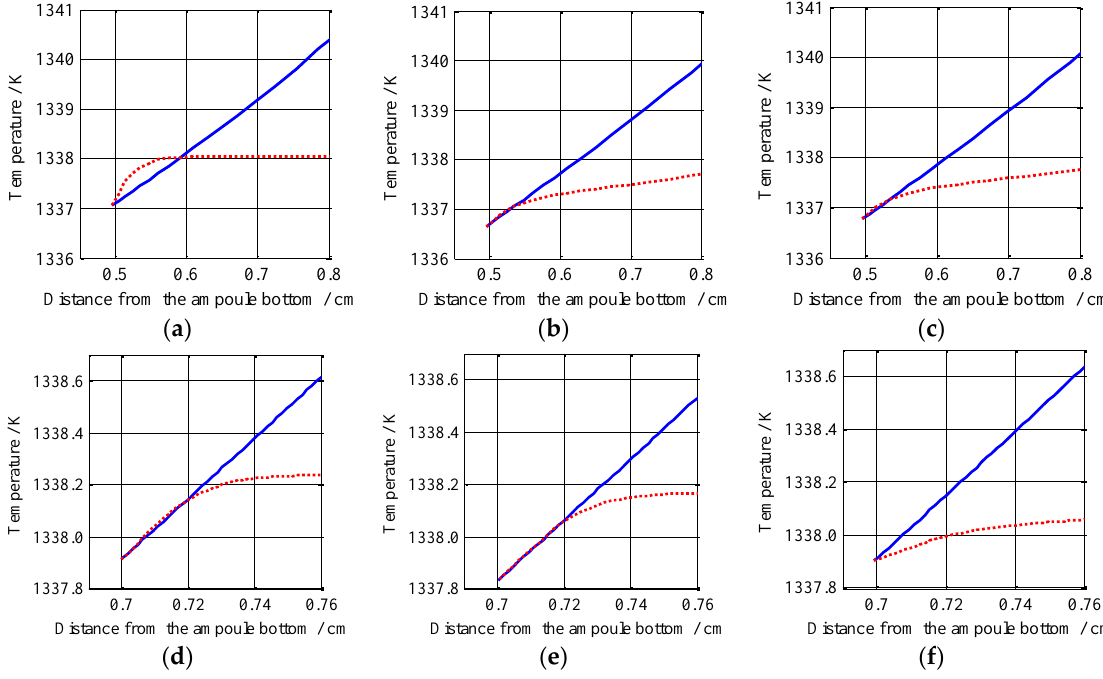
Figure 7. The actual (the blue solid curves) and the saturation (the red dashed curves) temperatures of the solution in front of Points O and P on the growth interface. Results for the solution in front of Point O at 5E of ACRT Sequences 1, 2, and 3 are shown in ( a ), ( b ), and ( c ), respectively. Results for the solution in front of Point P at 5C of ACRT Sequences 1, 2, and 3 are shown in ( d ), ( e ), and ( f ), respectively. For Point P, we plot the actual and the saturation temperatures of the solution along a plumb line (not vertical to the growth interface) at 5C for the three cases (Figure 7d–f). The temperature